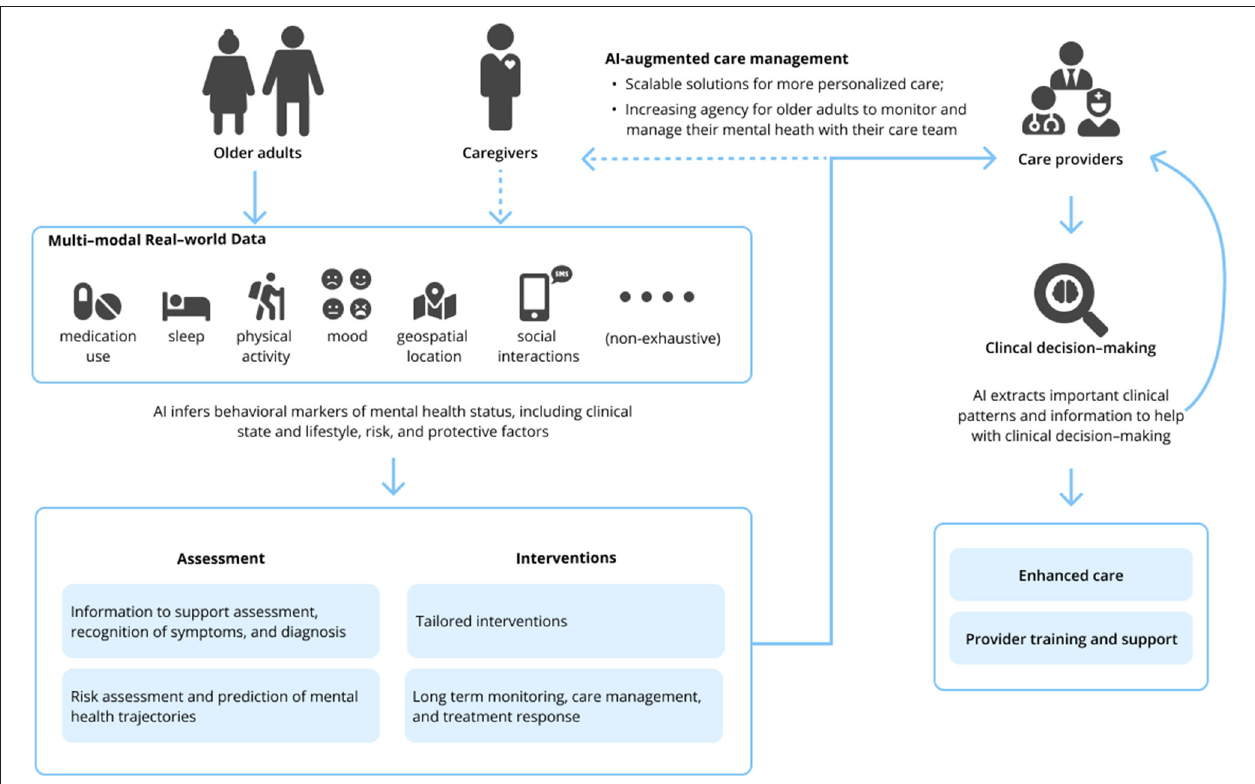
FIGURE 1 | Clinical opportunities for artificial intelligence in geriatric mental health